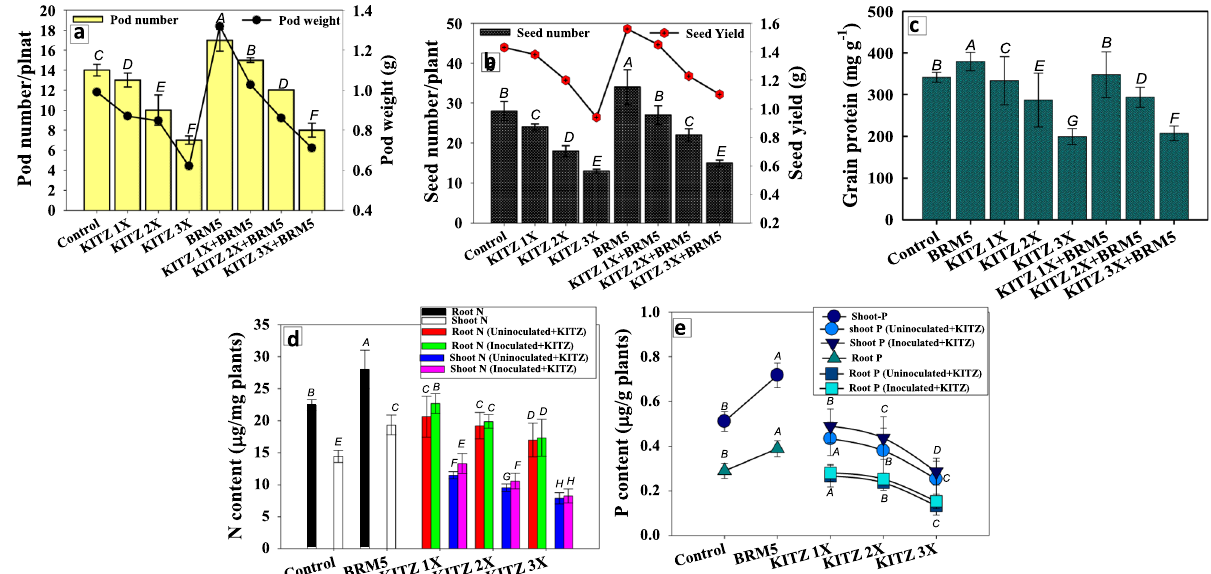
Figure 7. Bio-inoculation impact of M. ciceri BRM5 on C. arietinum plants on: pod number and yield ( a ), seed number and seed yield ( b ), grain protein ( c ), N content ( d ) and P content ( e ) grown in sandy clay loam soil treated with 96, 192 and 288 µg KTZ kg −1 soil. The bar and line diagrams represent the mean ± S.D ( n = 3) of three replicates where each replicate constituted three plants/pot. Mean values followed by different letters are significantly different at p ≤ 0.05 according to DMRT concentrations of KITZ. In general, strain BRM5 minimized the proline level even in the presence of fungicide. M. ciceri BRM5 significantly ( p ≤ 0.05) and maximally reduced the proline content in roots, shoots and seeds by 27%, 26% and 33% at the 1 × dose of KITZ (Fig. 8a,b) compared to un-inoculated plants treated with the identi- cal dose of fungicide. Similarly, it was observed that M. ciceri BRM5 reduced the MDA content from 5.4 to 3.07 µ moles g −1 fw compared to un-inoculated plants treated with 96 μg KITZ kg −1 (Fig. 8c). Information is lacking